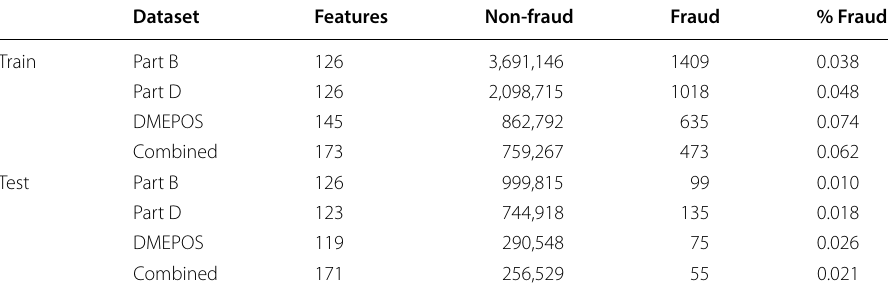
Table 3 Summary of final datasets: train and